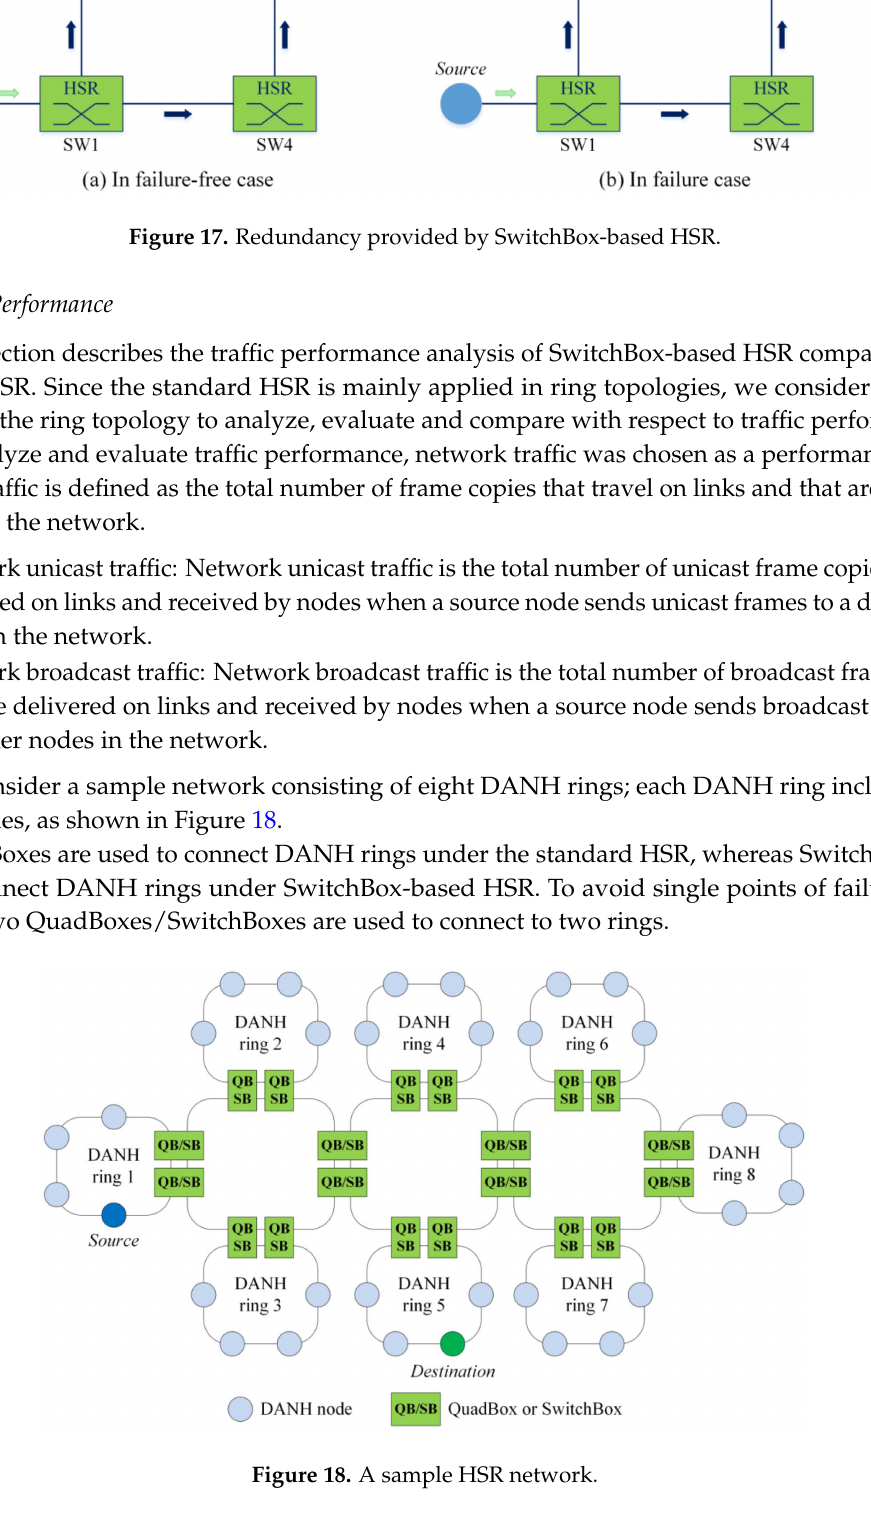
Figure 17b. SwitchBox SW3 looks up its MAC table and forwards the copy to the destination node. Therefore, SwitchBox-based HSR provides seamless redundancy with zero switchover time in case of network failure.